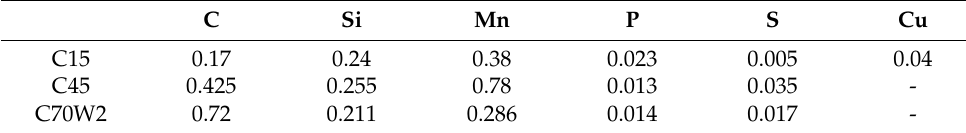
Table 1. Chemical composition of boronized steels, wt.%